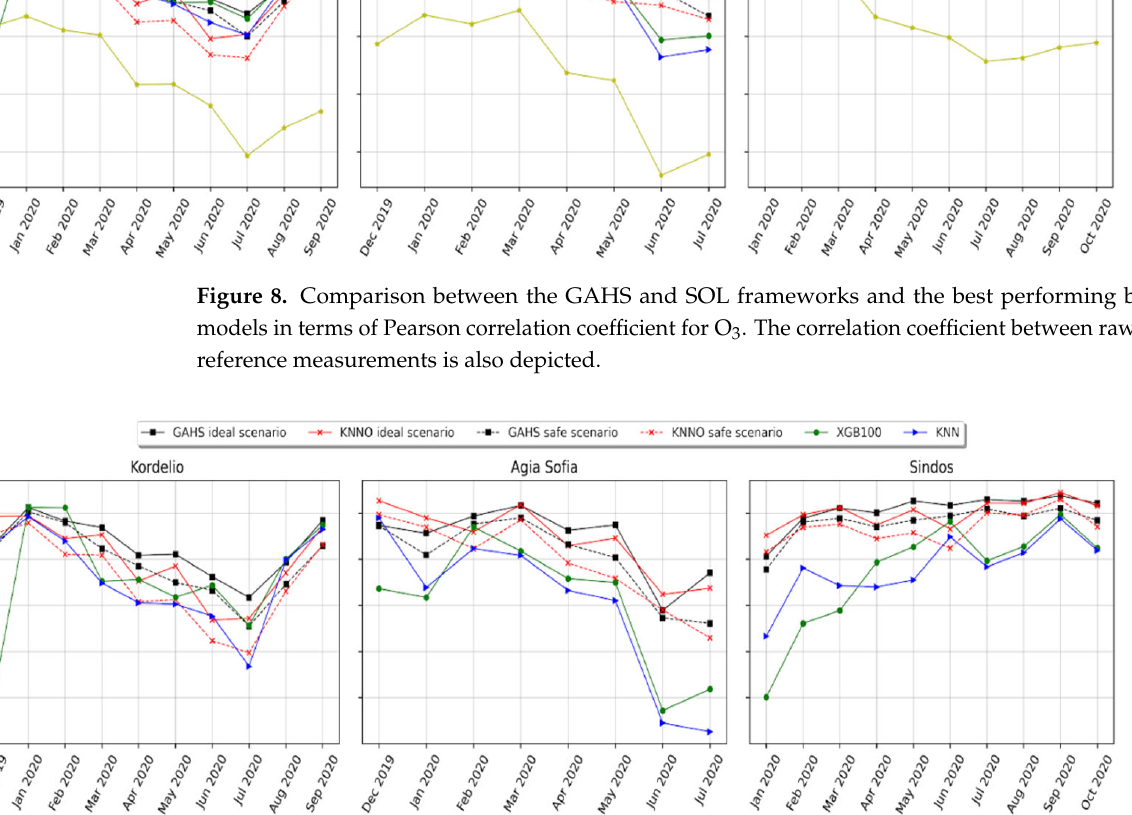
Figure 10. Comparison between the GAHS, and the SOL frameworks and the best performing batch models in terms of mean absolute error for O 3 . Particle counters demonstrate a more diverse functioning in Figures 11–13 and are evaluated for 24, 13, and 18 months in Kordelio, Agia Sofia, and Sindos, respectively, giv ‐ ing the opportunity to study the long ‐ term behavior of the sensors and their calibration. Focusing on R between the raw sensor data against the reference data, we observe that during the winter the relationship strengthens with higher correlation values and during summer periods the relationship is weakened. It also exhibits oscillatory behavior be ‐ tween months when a constant value was expected, which demonstrates the seasonal var ‐ iations’ role in the ability of the LCS to correctly capture particle ‐ related AQ. This indicates the presence of abrupt as well as recurring drifts leading to reduced performance. It is evident that the specific configuration of the sensors and, subsequently, the calibration procedure have a hard time modeling PM 10 during the summer period when the domestic heating emissions are low and dust contribution becomes more relevant. While we